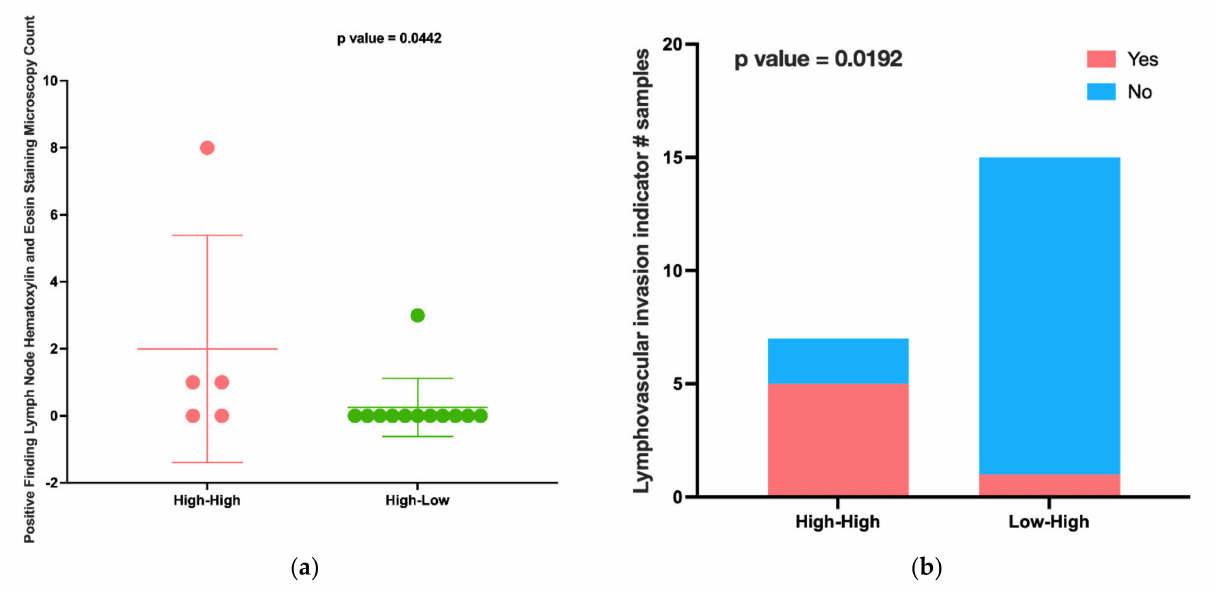
Figure 6. ( a ) High-high patients had more positive lymph nodes than high-low patients. ( b ) high-high patients had more lymphovascular invasions than low-high